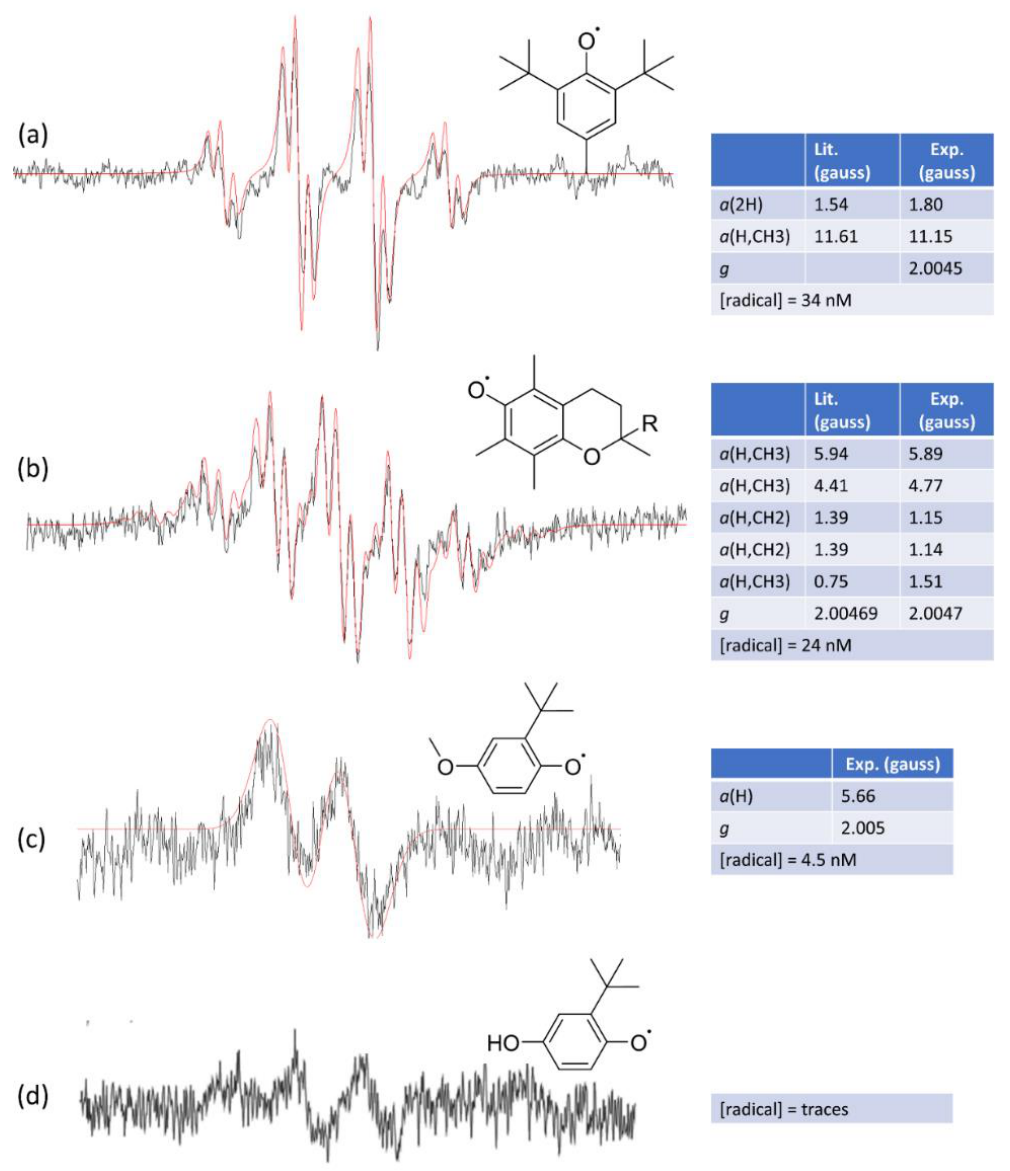
Figure 3. Experimental and simulated (red lines) EPR spectra of SSO after the addition of 0.1% at 40 °C of 3 ( a ), 7 ( b ), 2 ( c ), 10 ( d ). The coupling constants ( a ), the g -factor, and the radical concentrations (estimated error ± 50%) are also reported.